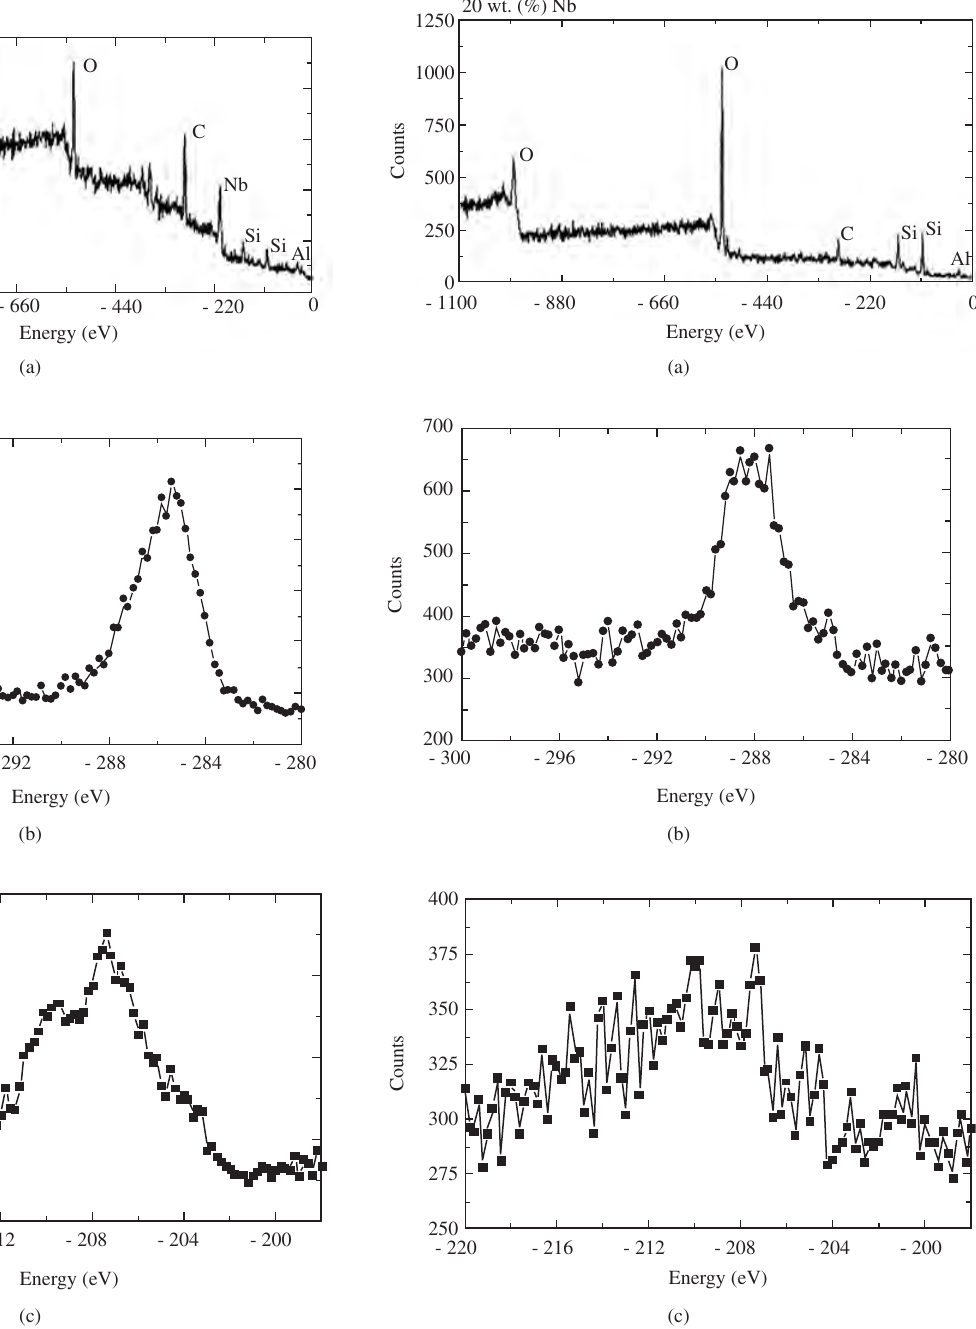
Figure 1. XPS analysis of the sample with 10 wt. (%) Nb, showing the spec- trum of: a) general chemical specimens; b) carbon; and c) niobium.